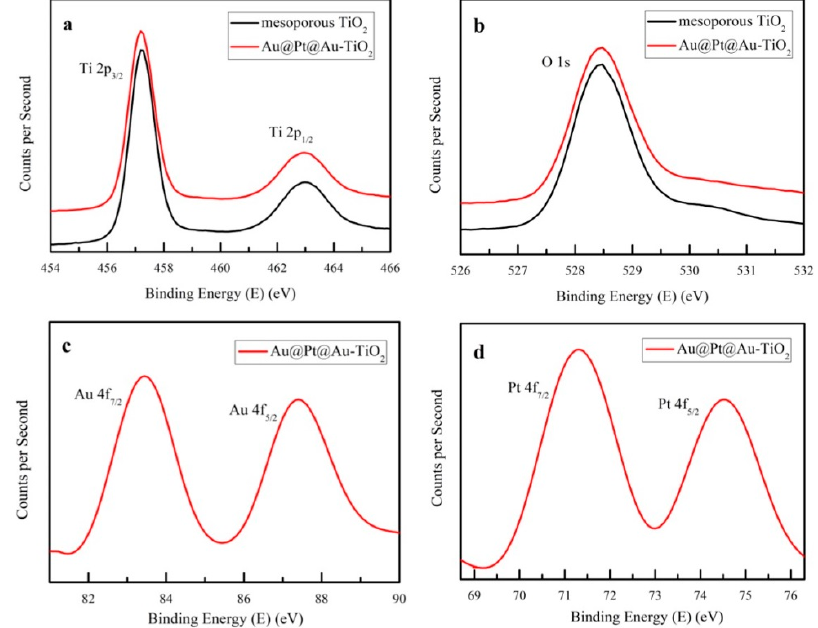
Figure 4. ( a ) Ti 2p, ( b ) O 1s, ( c ) Au 4f, and ( d ) Pt 4f XPS spectra of mesoporous TiO 2 samples and mesoporous TiO 2 samples incorporated with Au@Pt@Au core-shell NPs.